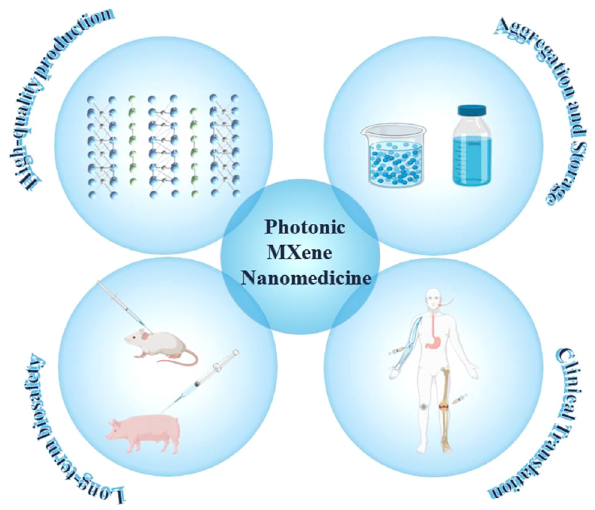
Figure 13: Schematic diagram of the developments and challenges of 2D MXenes for biomedical applications, including mass production, aggregation and storage, long-term biosafety, and clinical